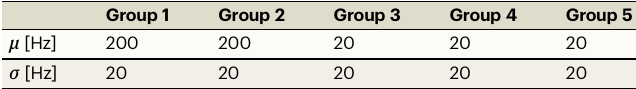
Table 2 | MF fi ring rate parameters used in the full model Group